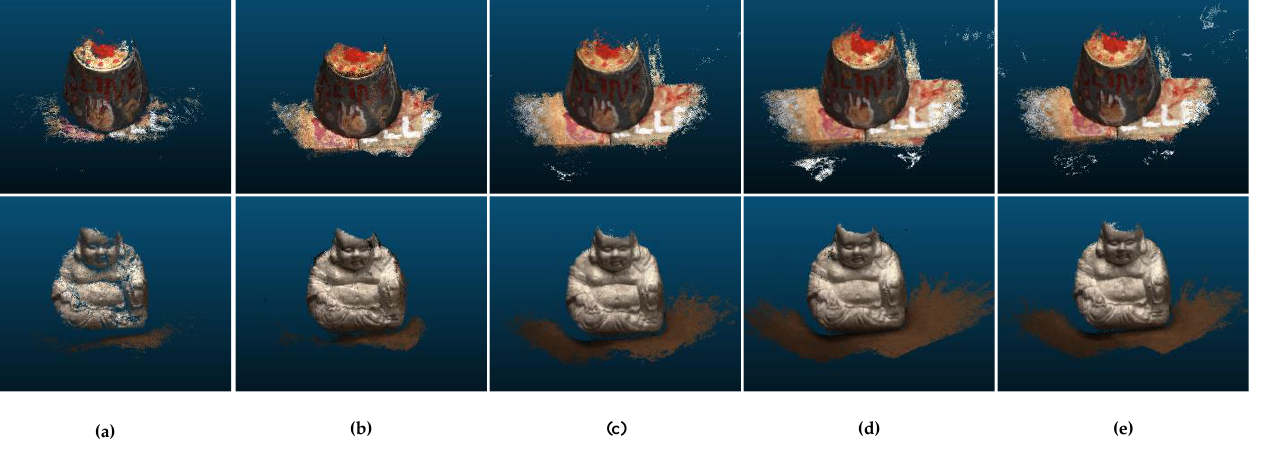
Figure 6. Reconstruction results of BlendedMVS dataset.